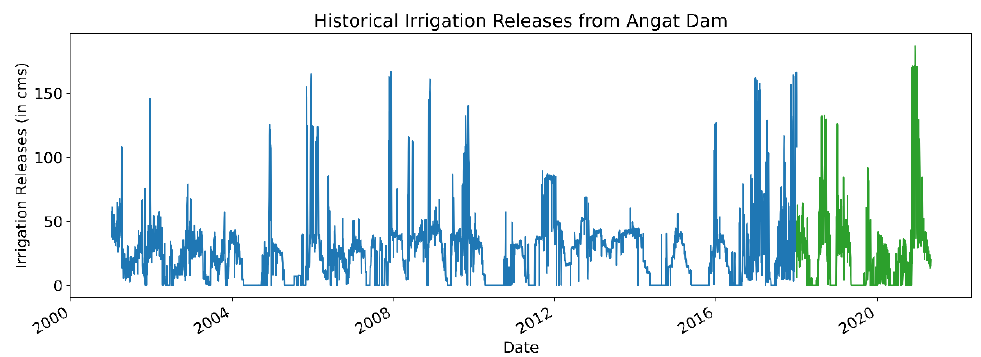
Figure 5. Historical irrigation releases from the Angat Dam in cubic meters per second (cms). As the Angat Dam is also the primary source of irrigation for nearby farmlands, a portion of the water stored is allocated regularly for irrigation use. Blue observations denote the training set and green observations denote the test set.